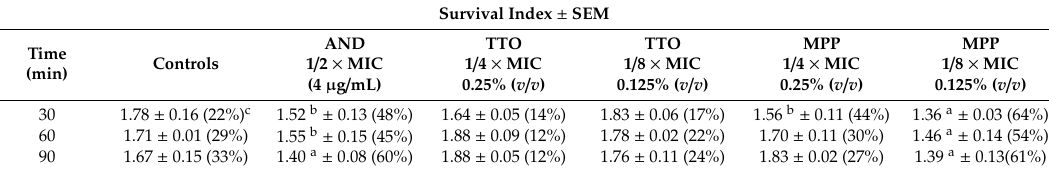
Table 4. E ff ect of 1 h of pre-exposure of human PMNs to anidulafungin (1 / 2 × MIC) or TTO or “Mentha of Pancalieri” essential oil (1 / 4 × MIC; 1 / 8 × MIC) on PMNs intracellular killing of Candida krusei . The PMN killing values were expressed as a Survival Index ± SEM (standard errors of the means), calculated as the number of surviving microorganisms at 30 min (T o ) plus the number of surviving microorganisms at T x divided by the number of surviving microorganisms at T o . Survival Index ± SEM AND Time Controls 1 / 2 × MIC (min) (4 µ g /